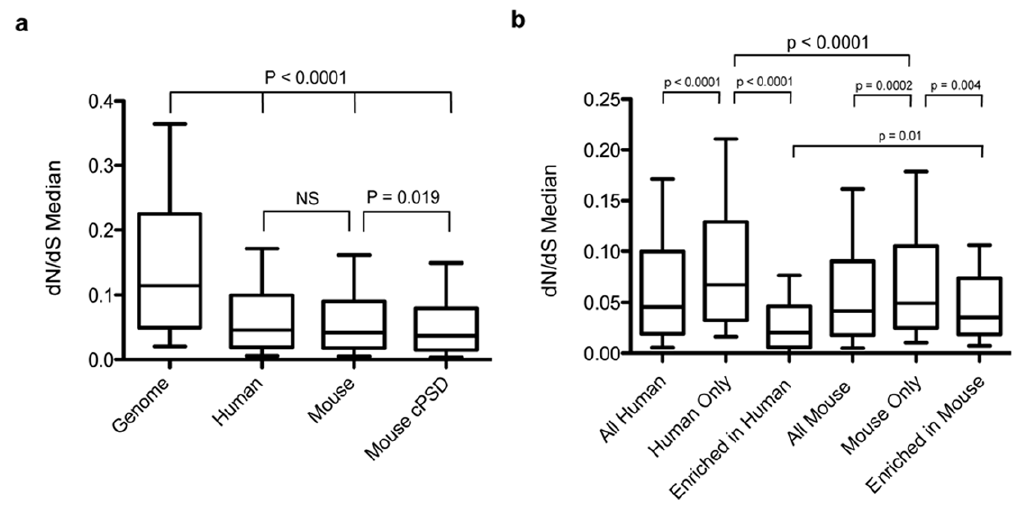
Figure 2. Analysis of evolutionary conservation of PSD proteins in mouse and humans. a. Median dN/dS of proteins identified in the human PSD, mouse PSD and mouse consensus set (cPSD) compared with the median genomic value. b. Comparison of dN/dS values in proteins exclusive or enriched in one species with all PSD proteins.